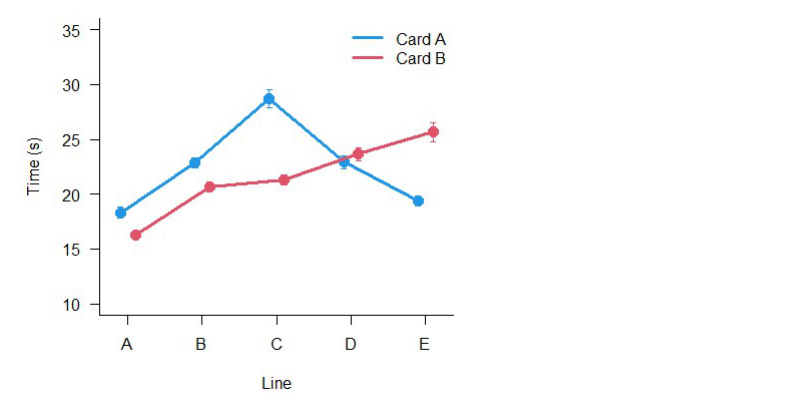
Figure 4. Mean execution times between the different lines (A–E) and the two Cards. Bars represent ±1 SEM.